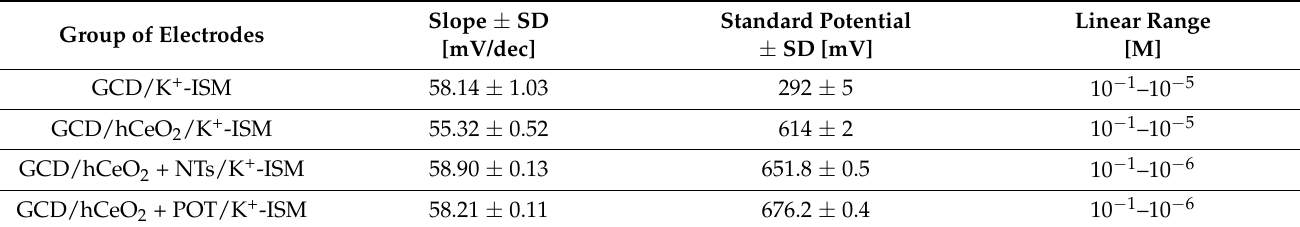
Table 2. Potentiometric response towards K + ions for studied electrodes after 24 h of electrodes’ conditioning in 0.01 M KCl ( n = 3